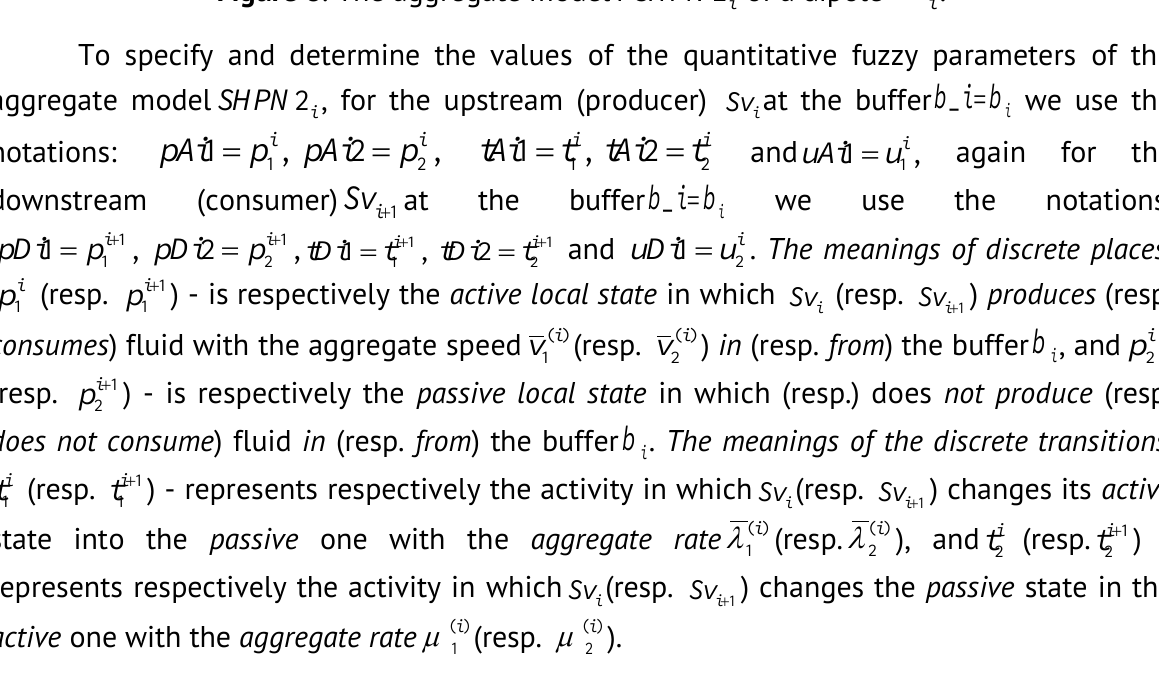
Figure 8 . The aggregate mоdel